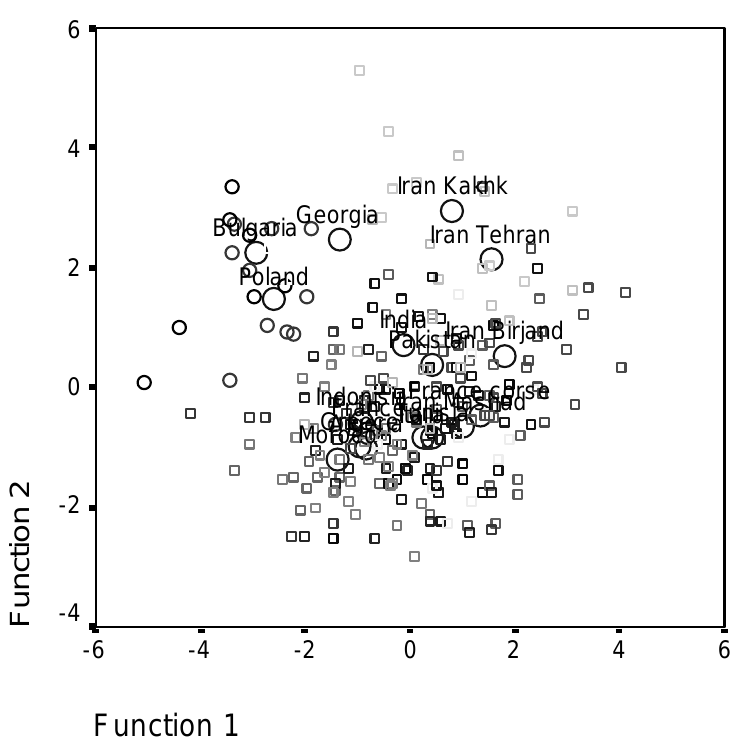
F IG . 5- Canonical Discriminant (CDA) based on First (1) and Second (2) Components. Multivariate